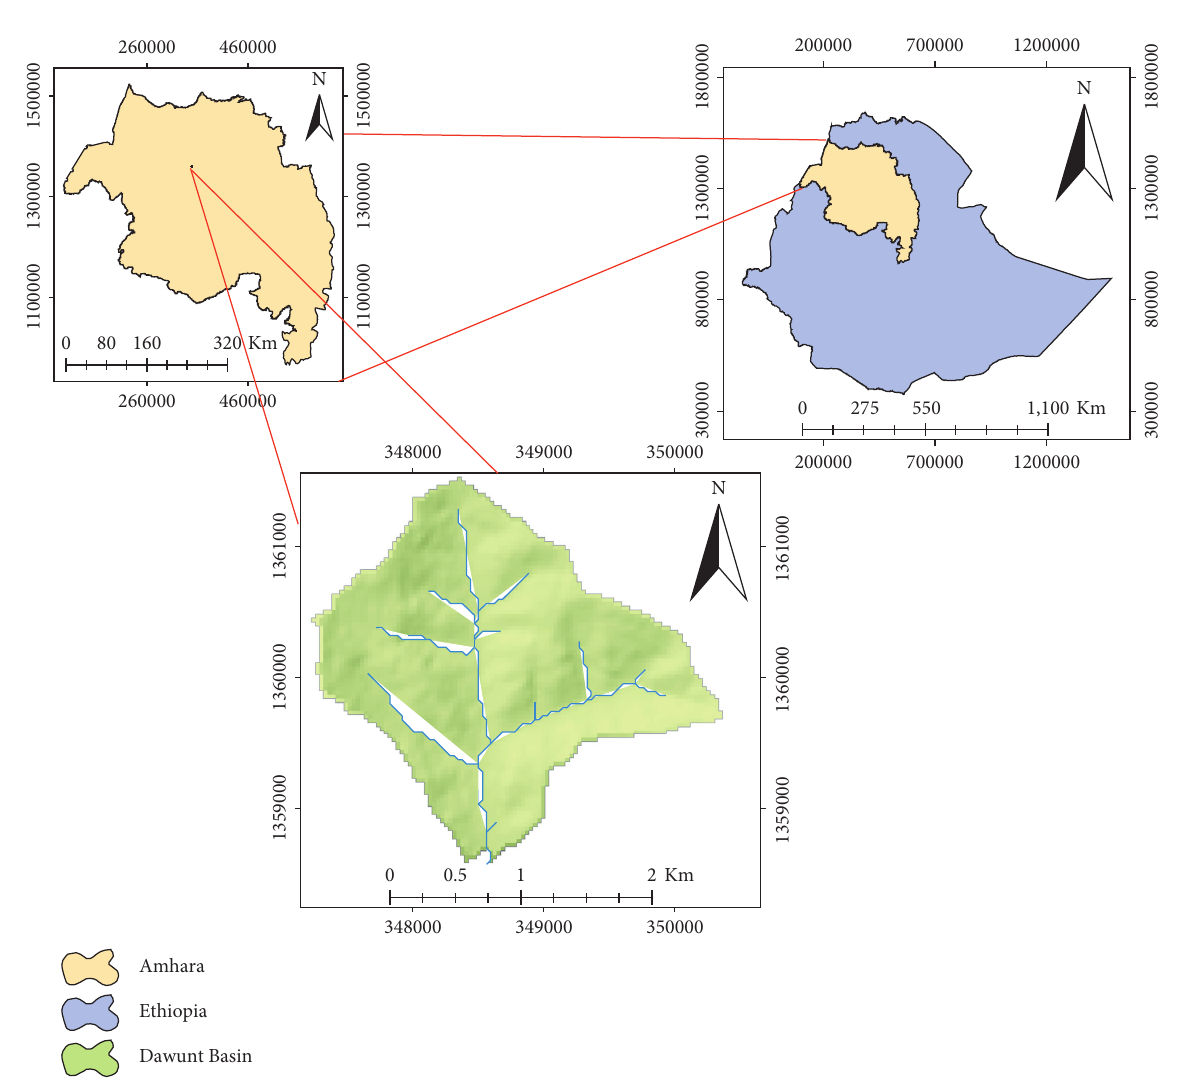
Figure 1: Location of Dawnt watershed in the northwestern Amhara region,